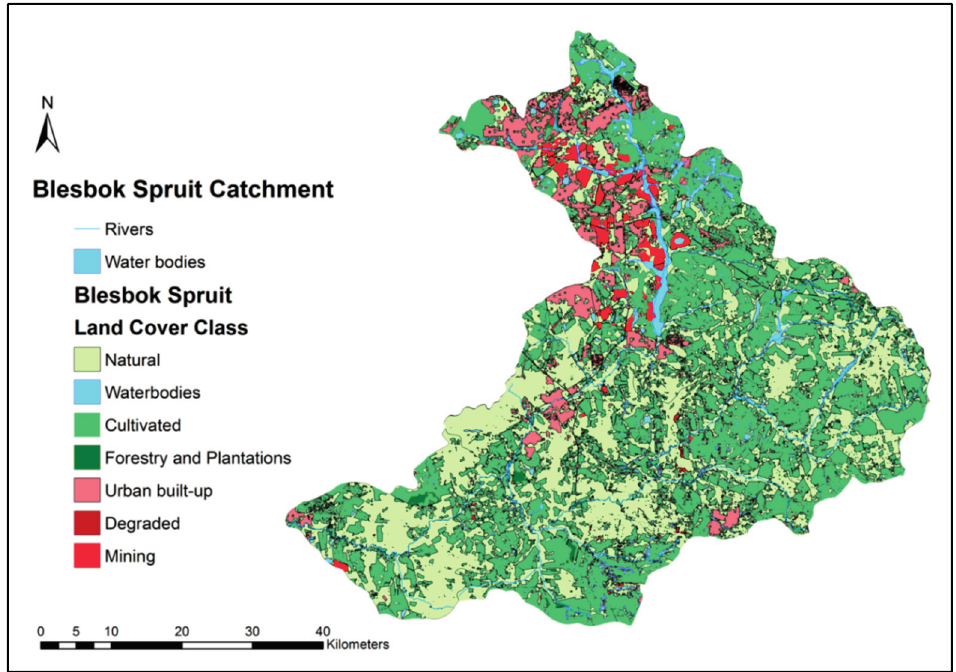
Figure 3. The land cover of the Blesbok Spruit catchment in 2009.